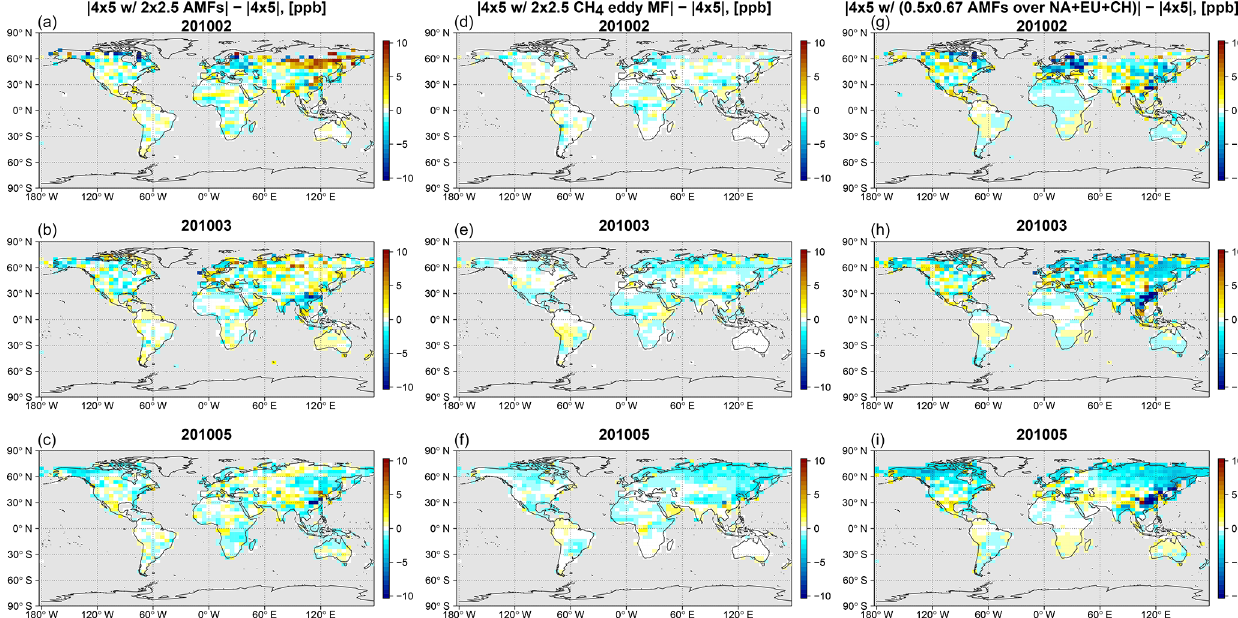
Figure 11. Change in the monthly mean absolute bias between the model and GOSAT XCH 4 in the R1 and R2 experiments for February, March, and May 2010 (rows 1–3). (a, b, c) Changes in the absolute bias for the R1 experiment (the “fixed” 4 ◦ × 5 ◦ simulation), which is driven by the regridded 2 ◦ × 2 . 5 ◦ hAMFs. (d, e, f) Changes in the absolute bias for the R1 experiment with the additional CH 4 eddy mass flux based on 2 ◦ × 2 . 5 ◦ simulation. (g, h, i) Changes in the absolute bias for the R2 experiment, which is the fixed simulation with the hAMFs over North America, Europe, and Asia replaced by the regridded 0 . 5 ◦ × 0 . 67 ◦ hAMFs. See the text in Sect. 5.4.1 for more details about the R1 and R2